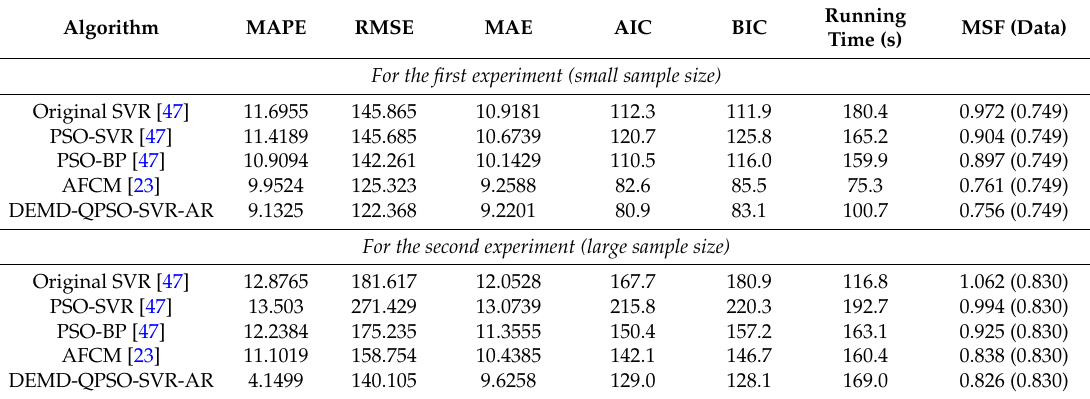
Table 7. Summary of results of the forecasting models in Case